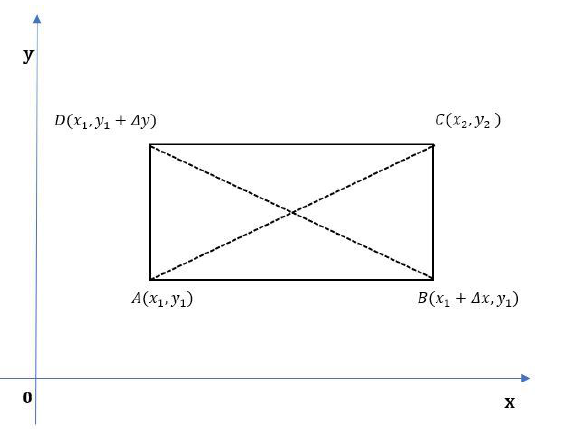
Figure 3. Construction of a